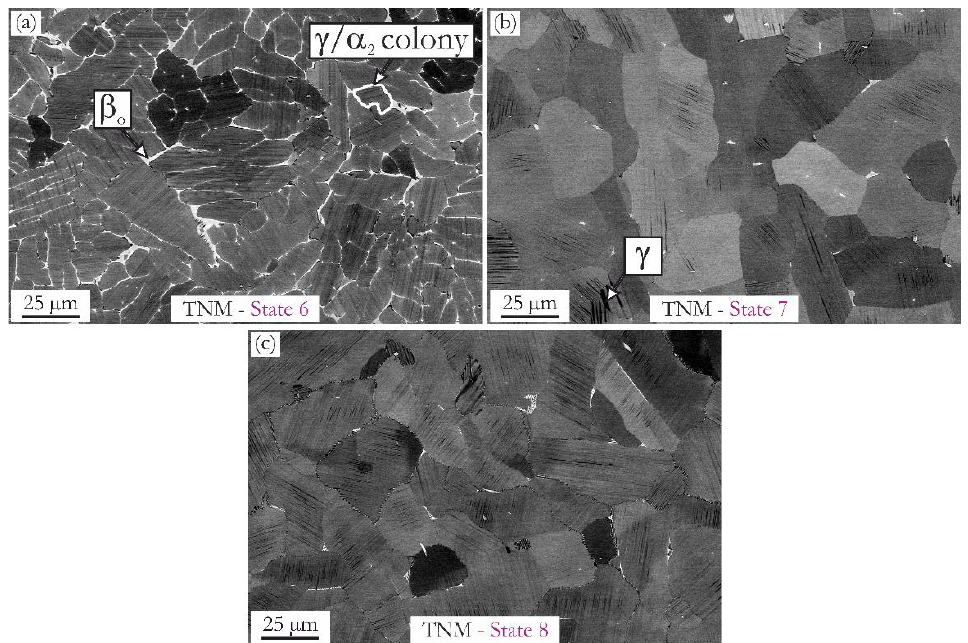
Figure 7. SEM-BSE images showing the microstructural evolution of the LPBF-TNM alloy during the heat treatment procedure 4 to obtain an AFL microstructure; ( a – c ) show the microstructure after the individual steps (states 6 – 8 as indicated in Figure 2d; see text for details). The building direction is vertical for all micrographs.